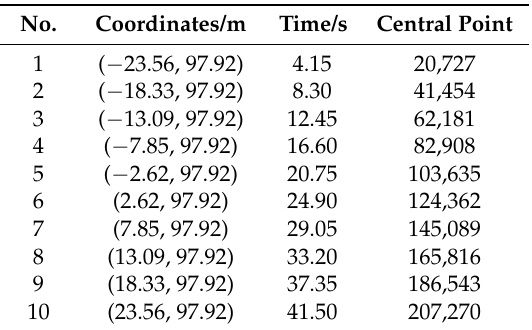
Table 1. Point information of path A → B.